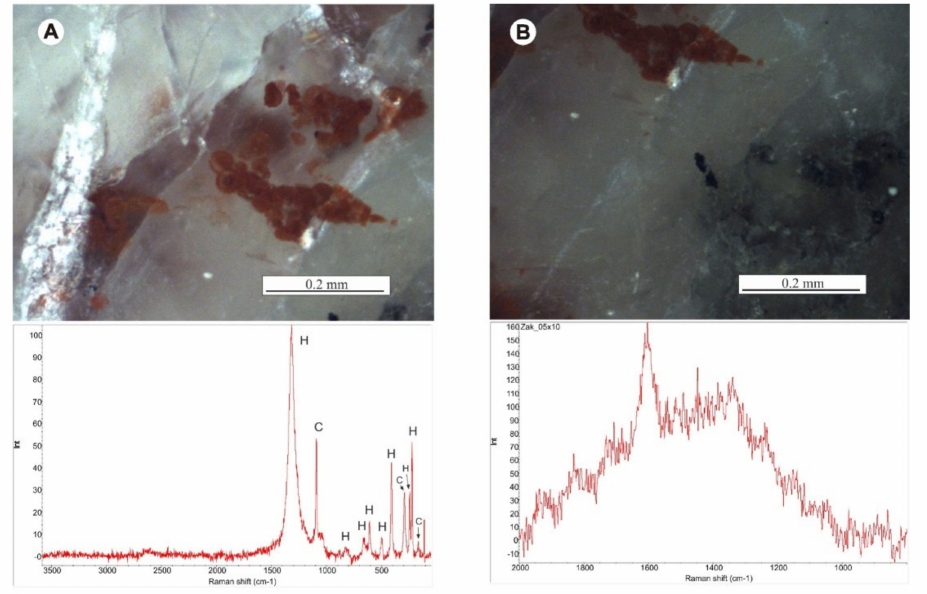
Figure 8. Photomicrographs and Raman spectra for solid inclusions of ( A ) hematite and ( B ) organic matter in the Zakrzyn IG 1 borehole (depth 4905.4